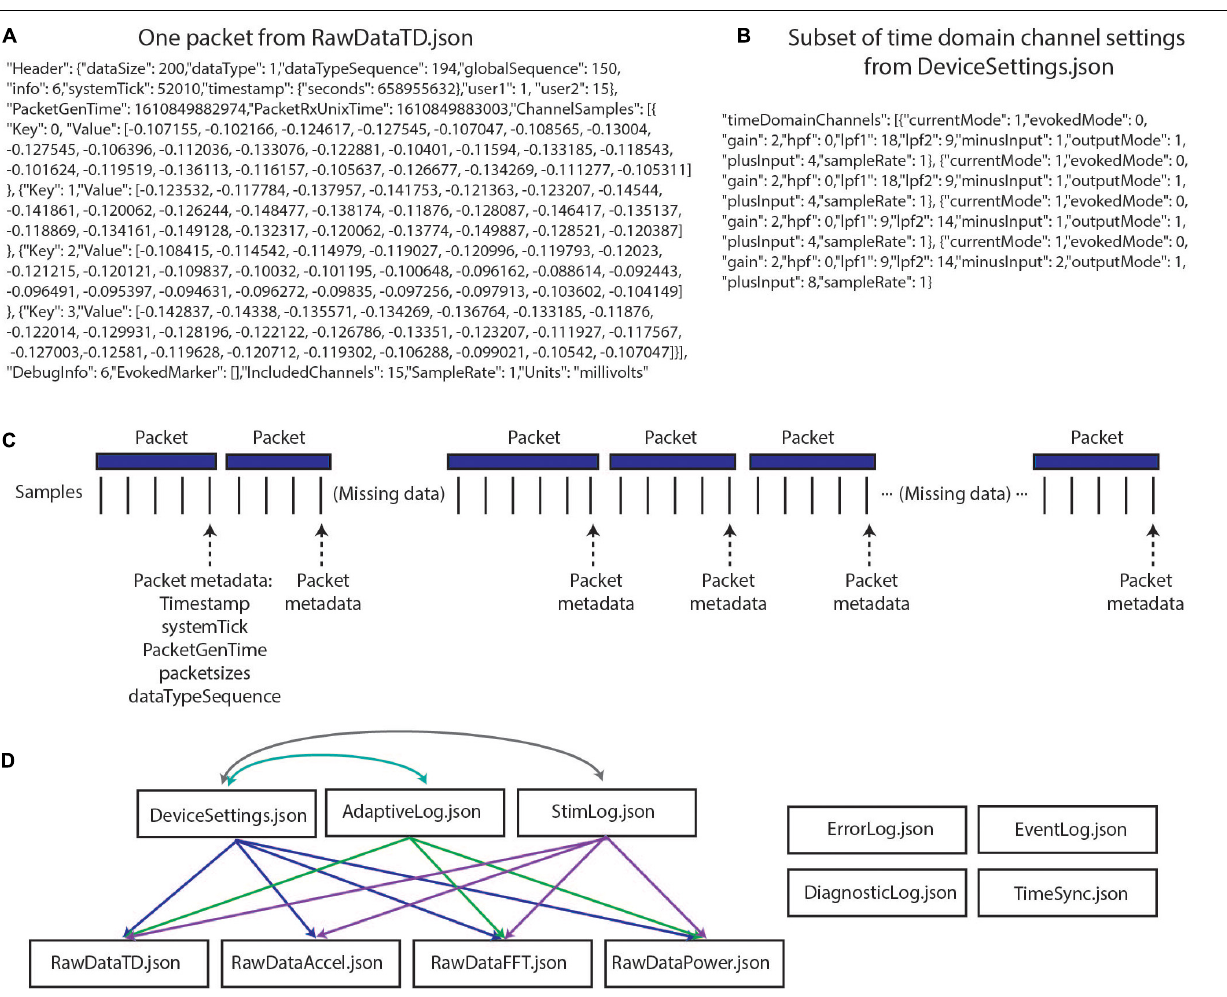
FIGURE 1 | Summit RC+S raw data structure. (A) One packet of data from RawDataTD.json; each packet contains one set of timing values and a variable number of time domain samples from each streamed channel; values such as SampleRate must be converted to interpretable values (e.g., Hz). (B) One section of values from DeviceSettings.json which provides information on time domain channel settings; mode, gain values, high pass and low pass filter settings, and contacts must be decoded to interpretable values. (C) Each time series stream transmits data from the INS in packets of variable sizes using UDP; receipt verification is not performed, so packets may not be received or may be received out of order. Each packet contains one value of timing information per variable, aligned to the last sample in the packet. Each data stream transmits packets separately, with non-aligned timing information. (D) The present toolbox is compatible with raw RC+S data which are acquired in 11 JSON files. This relationship diagram depicts that information from multiple files is required to interpret the recordings. For example, interpretation of RawDataTD.json may require all other JSON files which are connected to it via arrows. Colors are used to aid